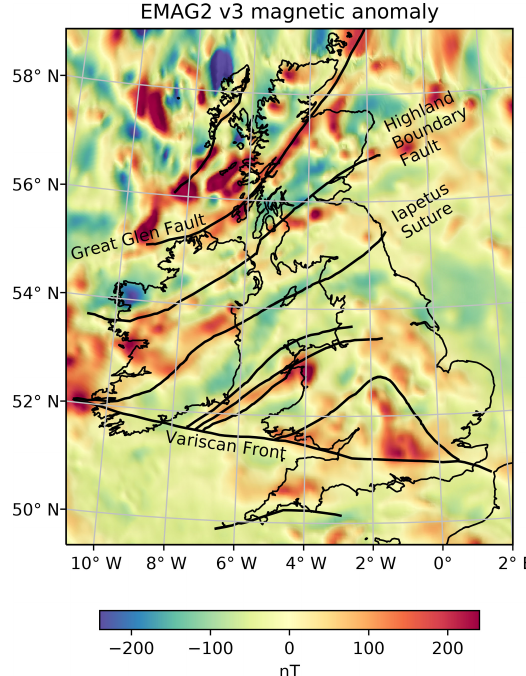
Figure 4. Magnetic anomaly map of the British Isles, extracted from the EMAG2 version 3 global compilation (Meyer et al., 2017) and overlain with structural information adapted from Tomlinson et al. (2006). The Iapetus represents the boundary between Laurentia and Avalonia.